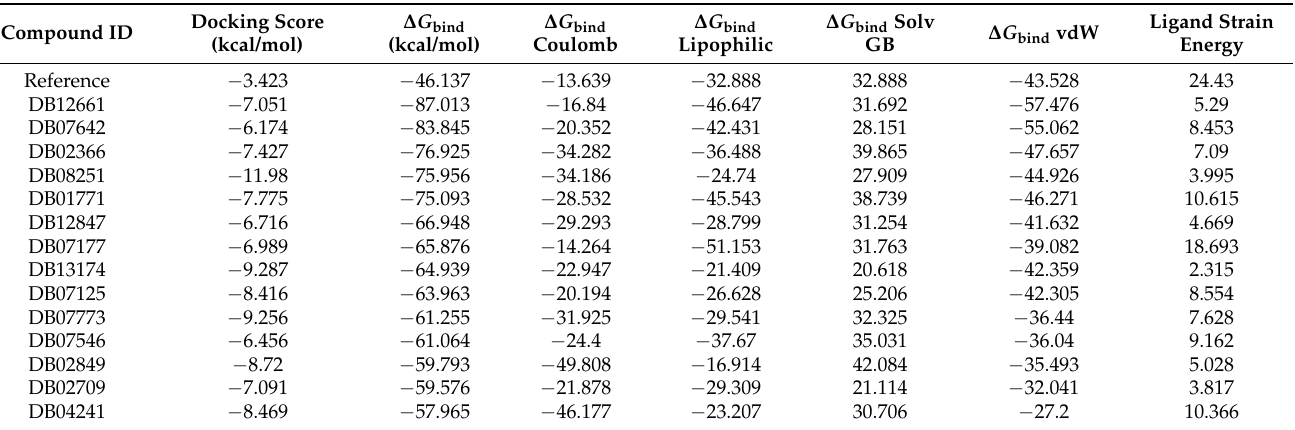
Table 2. Molecular docking and binding free energy calculations of hit compounds against MEK1 receptor.